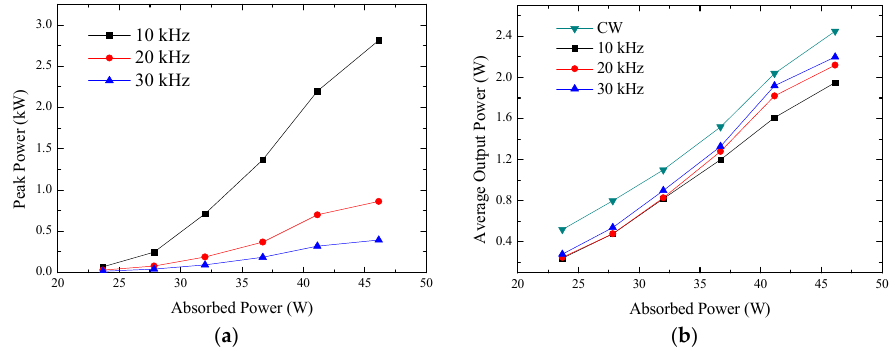
Figure 6. Peak power ( a ) and average power ( b ) versus absorbed power at different PRFs.